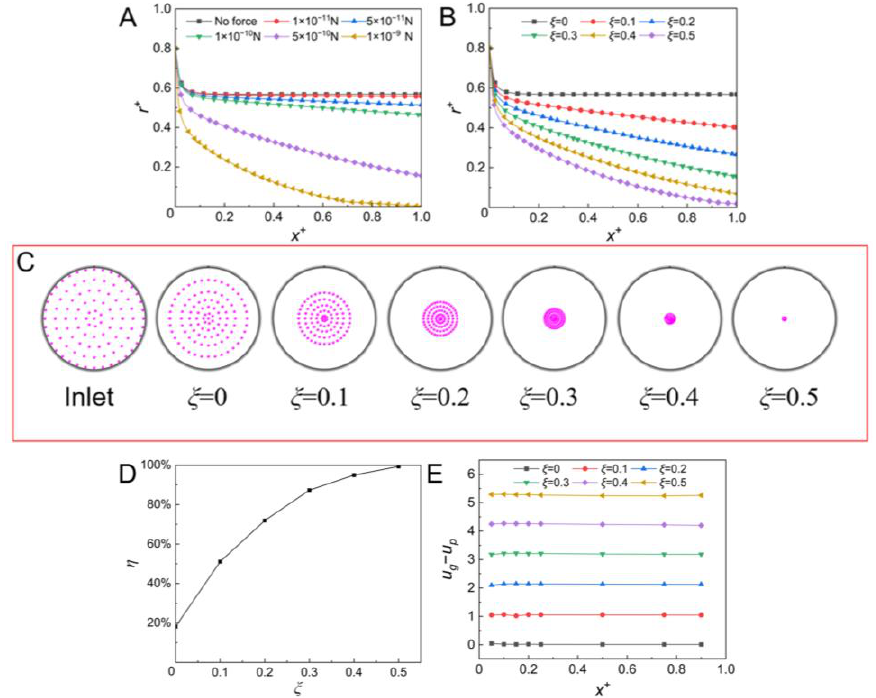
Figure 5. ( A , B ) Particle trajectories under the reverse external force with different magnitudes (particles were released from r + = 0.8, and ξ was defined as the ratio of the reverse external force to the Stokes force); ( C ) particle distributions at the inlet and outlet of the straight channel at different ξ ; ( D ) the particle focusing efficiency η at different ξ ; ( E ) velocity difference between the aerosol particle and the gas at different ξ . ( u = 10 m/s, d p = 1 μm, ρ p = 1550 kg/m 3 ).